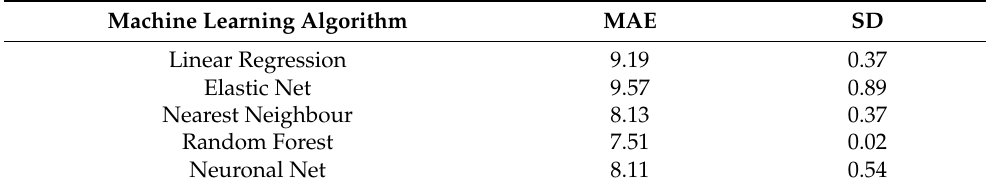
Table 4. Performance results (combined mean absolute error, MAE for all 6 target values) of various other machine learning algorithms obtained in 10-fold cross validation.